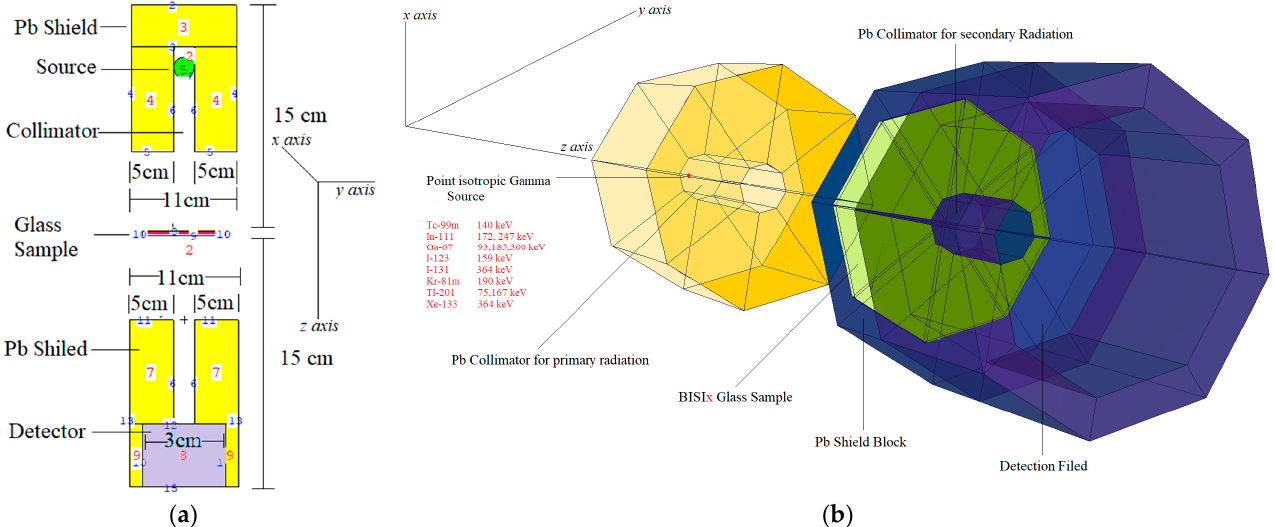
Figure 1. ( a ) Modeled point isotropic radioactive source obtained from MCNPX visual editor; ( b ) 2D view of simulation setup obtained from MCNPX visual editor.